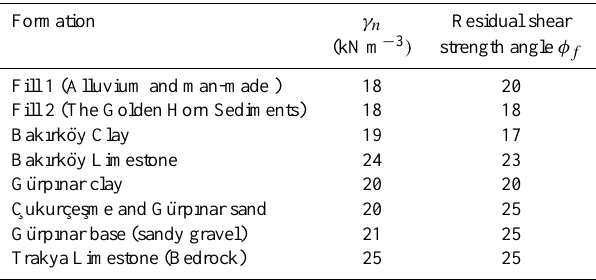
Figure 11. Comparison of the Regional Damage Map of the 1894 Earthquake (Lav, 1994) and Fig. 11. Comparison of the Regional Damage Map of the 1894 the ground shaking microzonation map prepared for probability of exceedance of 10% in 50 earthquake (Lav, 1994) and the ground-shaking microzonation map years. ( İ nce, 2005). prepared for probability of exceedance of 10% in 50yr (˙Ince, 2005).